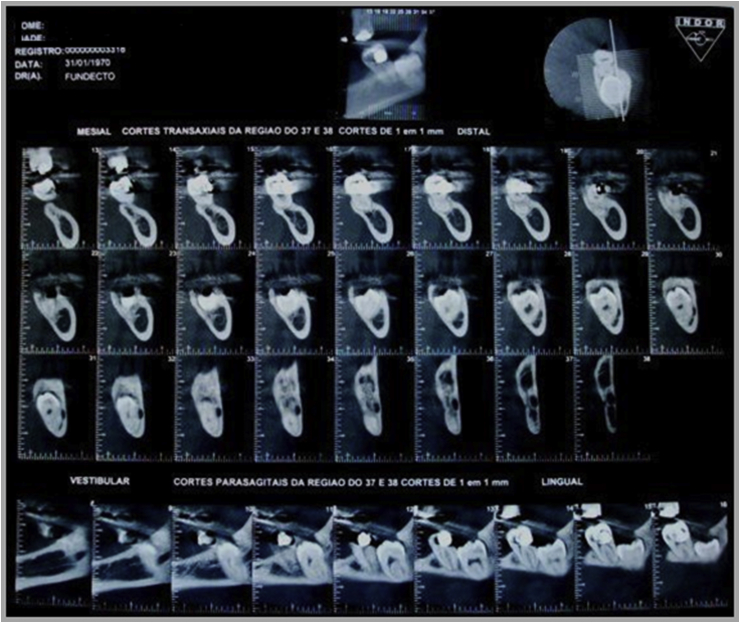
Pre operative CT.